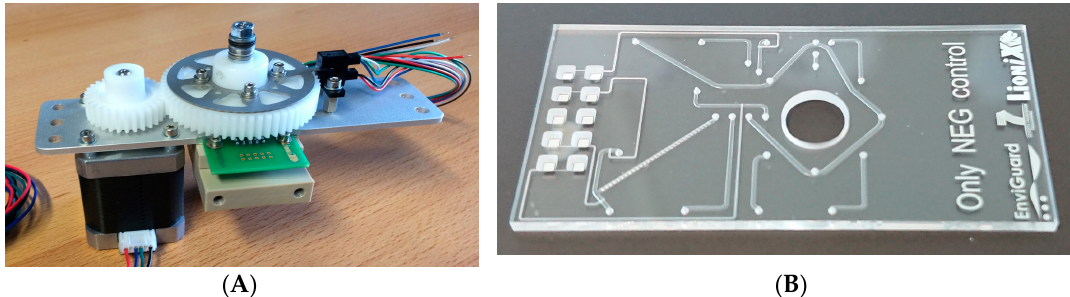
Figure 5. ( A ) Photograph of the assembled rotary valve. The rotor is turned by means of the stepper motor, which drives the large gear on top of the rotor. A light switch is used to detect the zero-position of the valve. Disc-springs are present on the axle to provide the compression force needed between the rotor and the valve-chip in order to obtain a leaktight connection. ( B ) Valve fluidic chip.